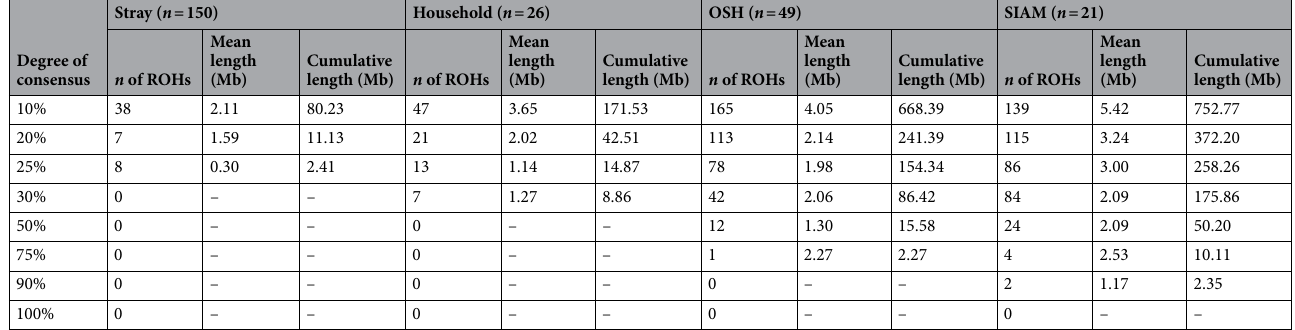
Table 3. Overview on the number and length of the ROHs (ROH5) shared by at least 10, 20, 25, 30, 50, 75, 90, or 100% of the genotyped cats in OSH, SIAM, stray and household, respectively. For all degrees of consensus, the number ( n ) and the mean length of ROHs found as well as the cumulative length of all ROHs are